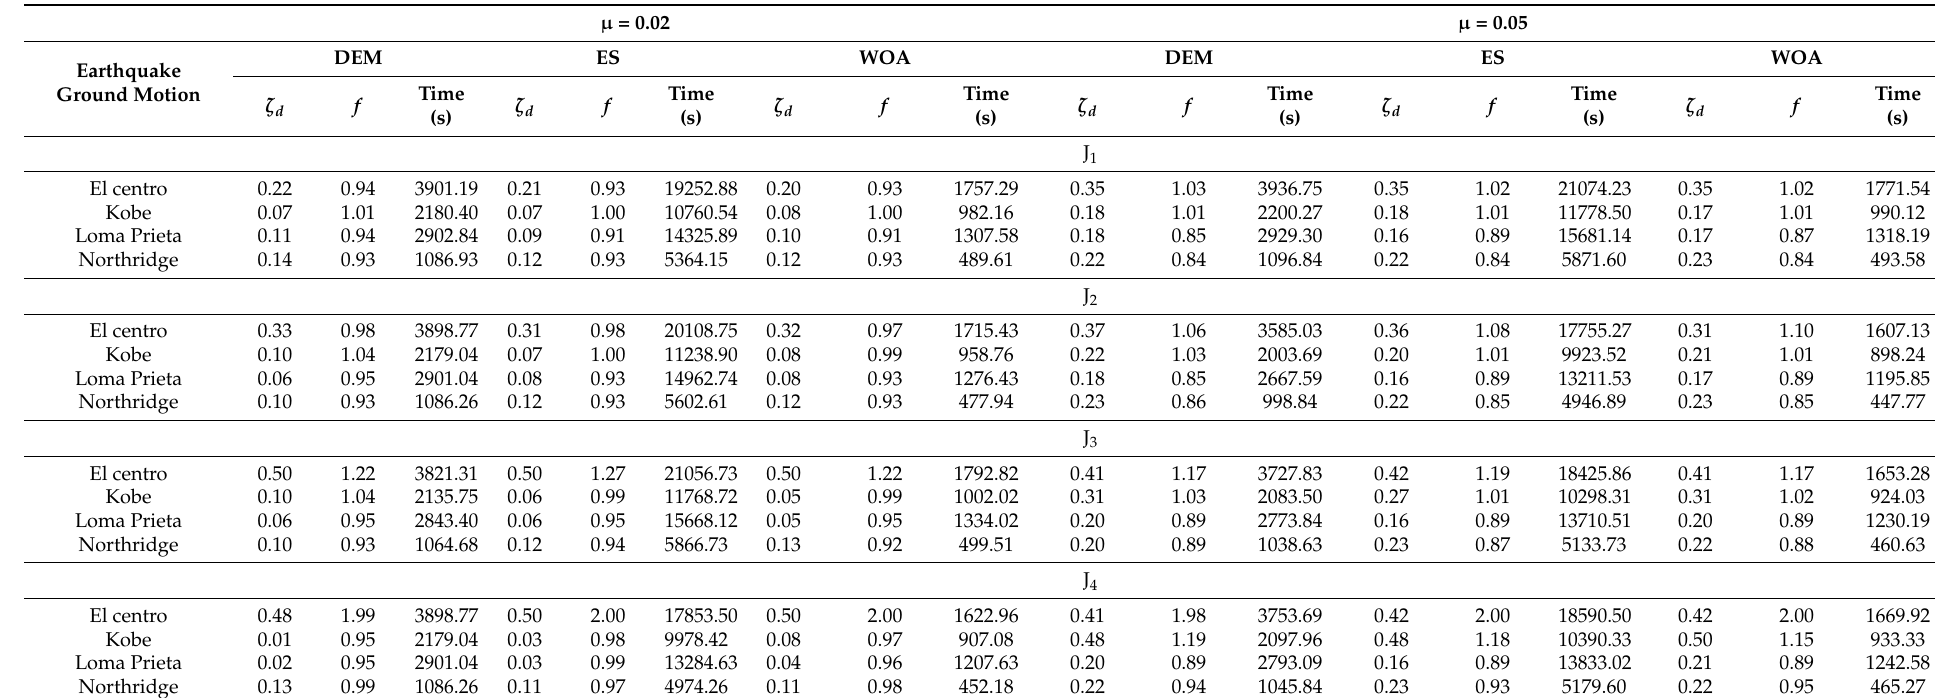
Table 4. TMD design parameters optimized by objective function J 1 , J 2 , J 3 , and J 4 . µ = 0.02 µ =